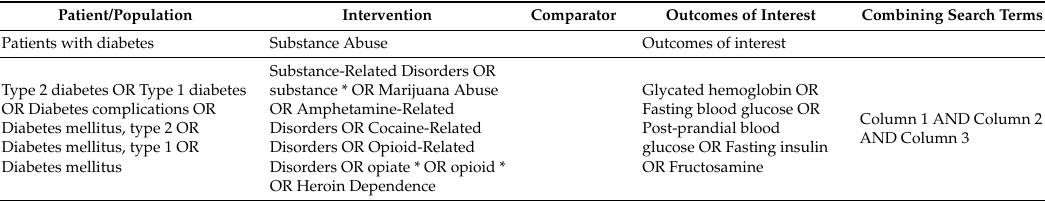
Table 1. Search Terms and Search